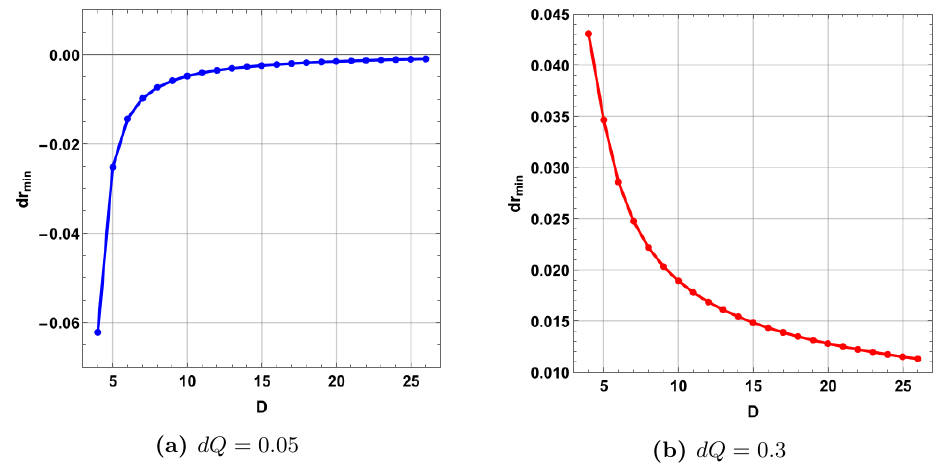
Figure 7. Variation of the minimum point dr min as a function of spacetime dimensions in extremal black holes for different absorbed particle charge dQ with | p r